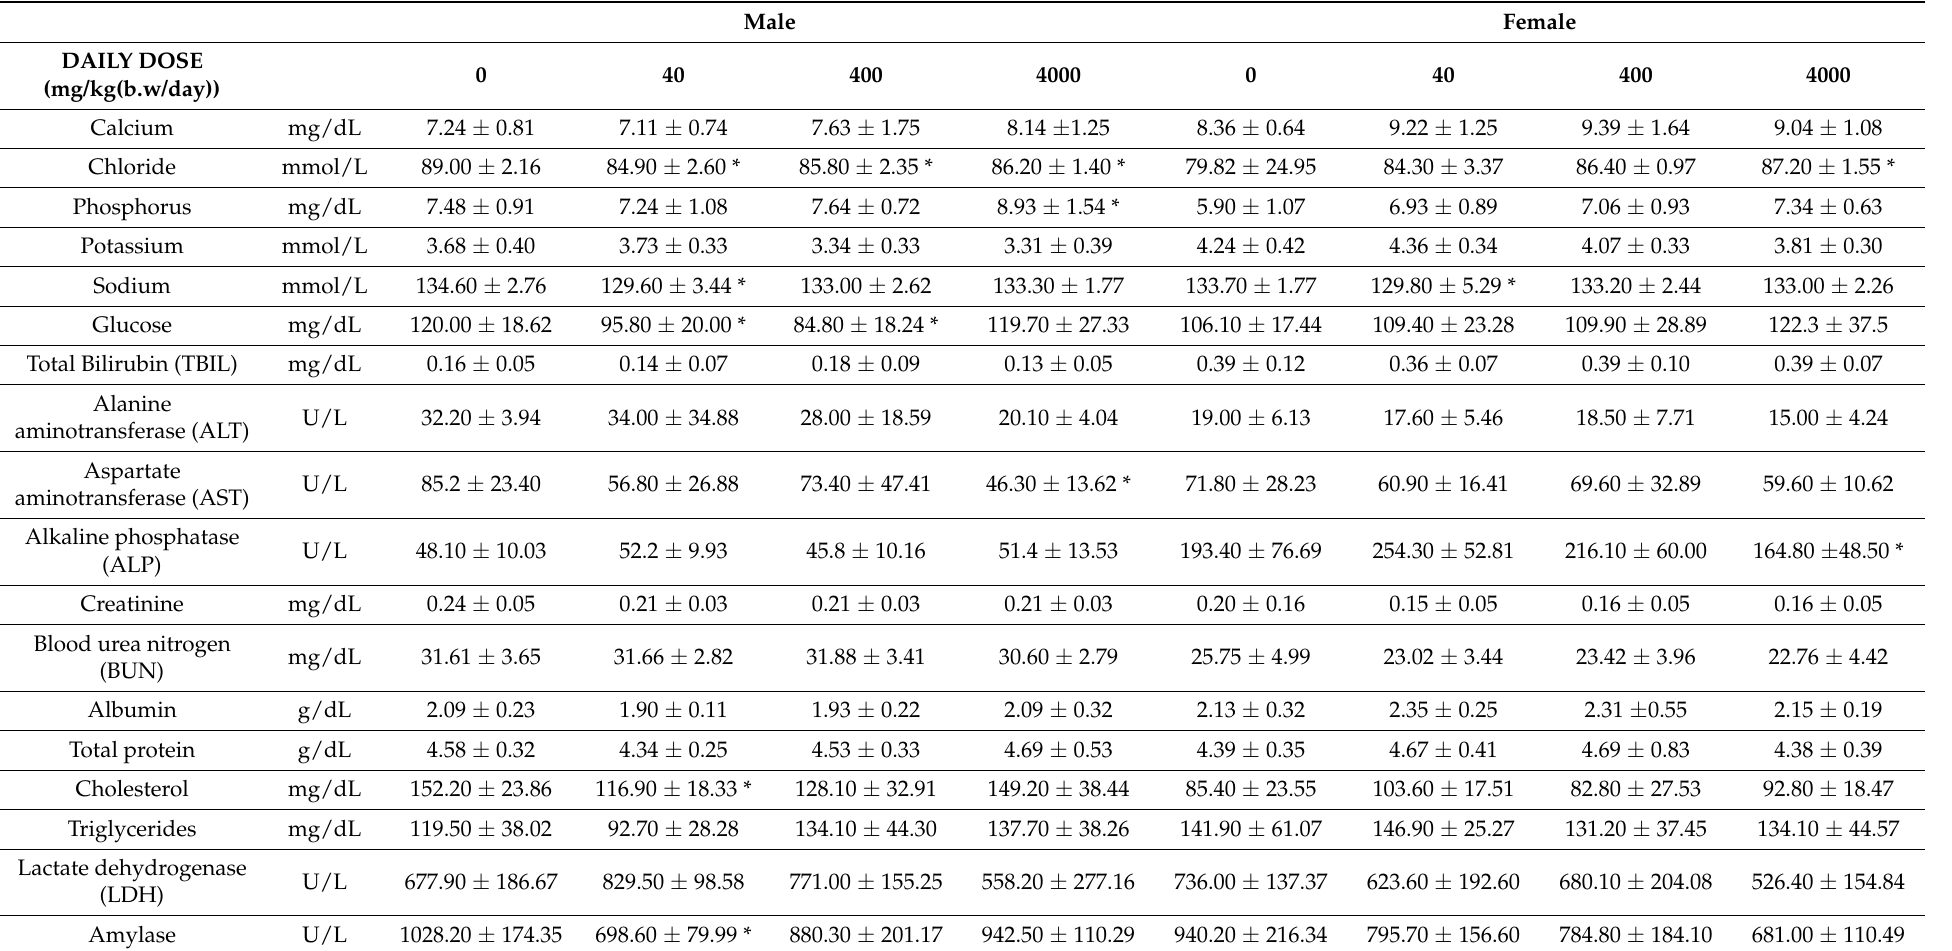
Table 6. Biochemical analysis of subacute toxicity after 28-day PS23 treatment on ICR mice. Male